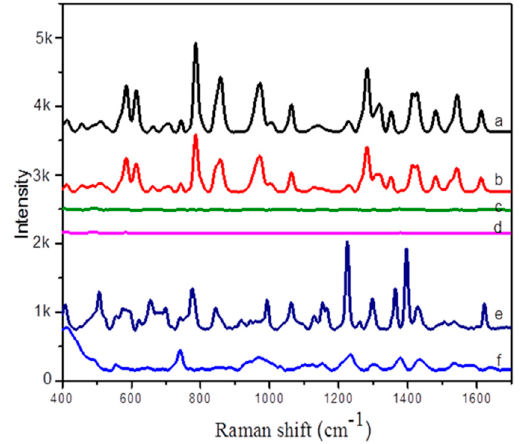
Figure 5. Spectra of flumetsulam (1000 µ g / L) adsorbed on different AuNPs substrates (a: on the two-step modified concentrated AuNPs substrate. b: on AuNPs substrate with an additional MgSO 4 added but without NaCl modification. c: on AuNPs substrate without any modification or extra addition. d: on AuNPs substrate with only NaCl modification). e: normal Raman spectrum of flumetsulam powder. f: blank solution on the two-step modified concentrated AuNPs substrate.